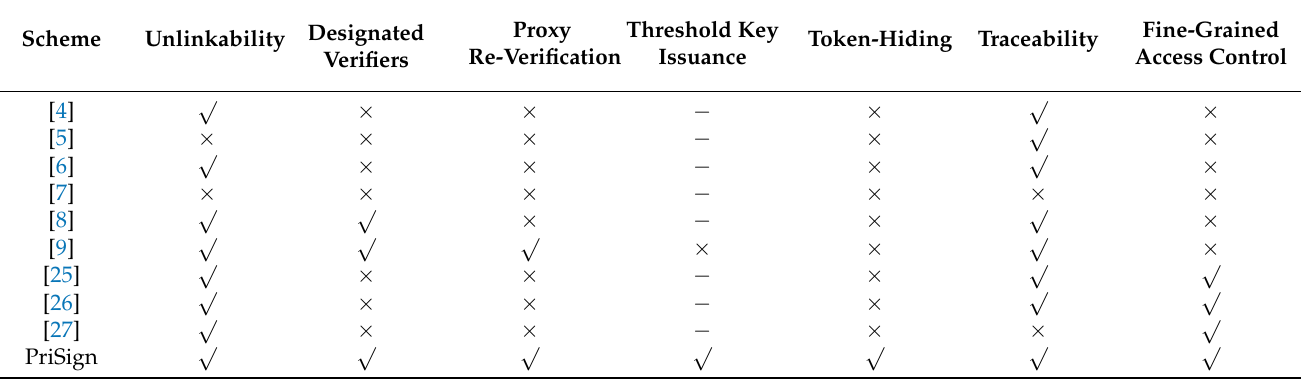
Table 1. Functional